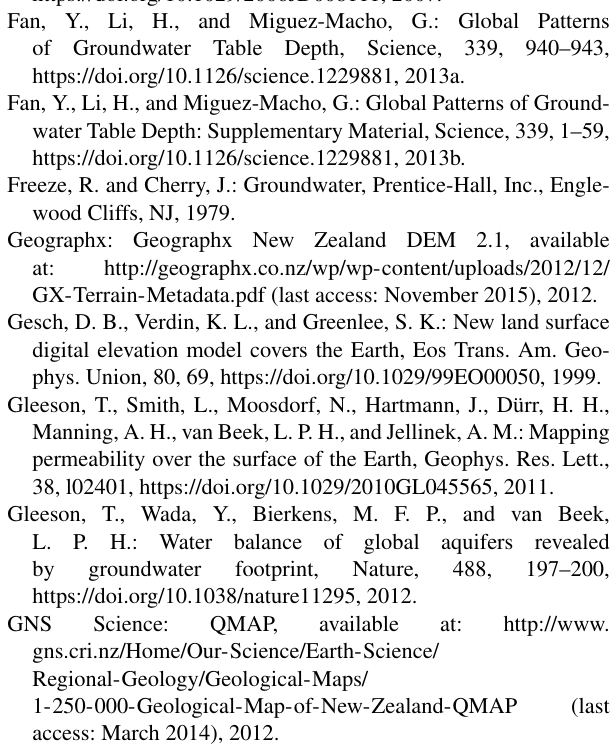
mate modeling: 1. Water table observations and equilibrium water table simulations, J. Geophys. Res., 112, D10125,